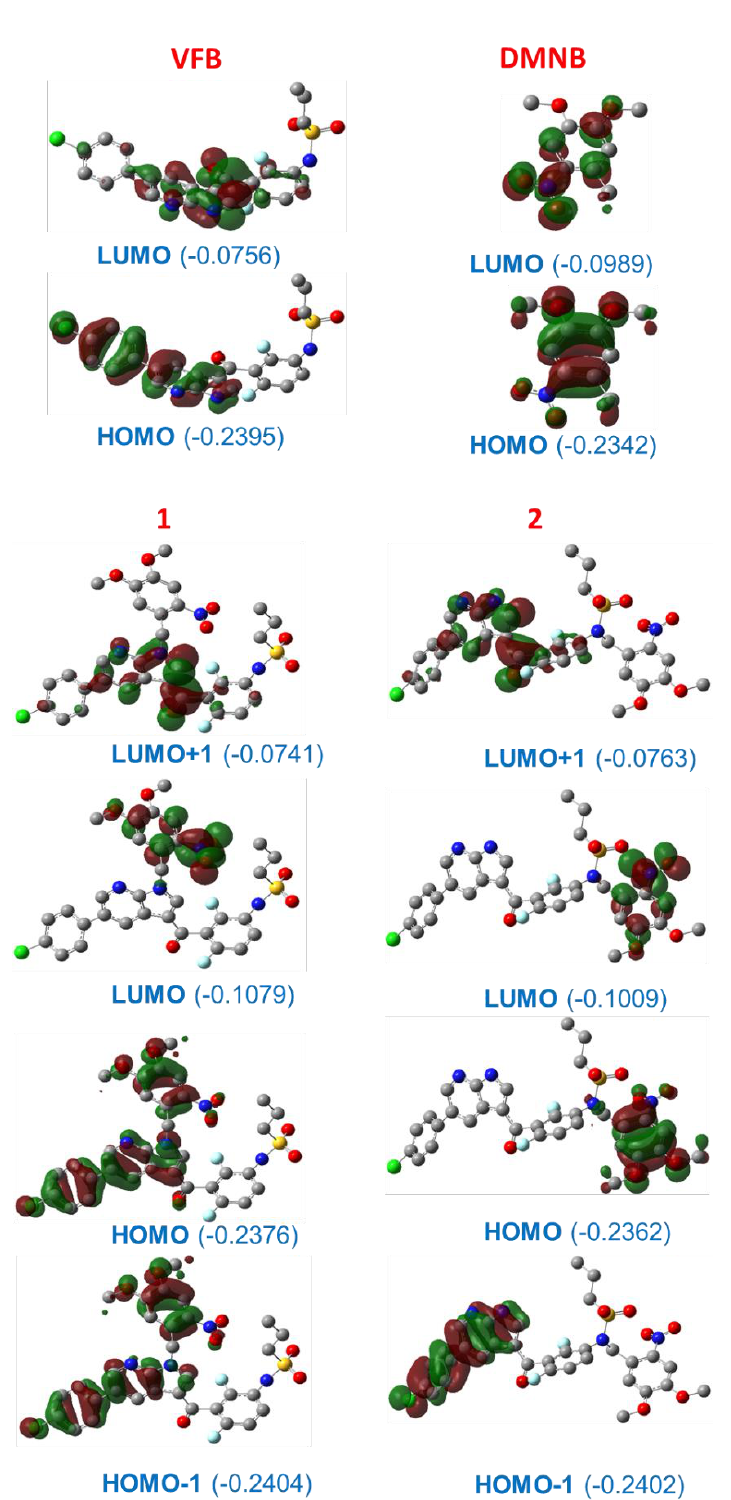
Figure 6. The frontier molecular orbitals (Mos) of VFB, DMNB, 1 , and 2 ; numbers in brackets refer to energy in hartree; uninvolved hydrogen atoms are omitted for clarity.